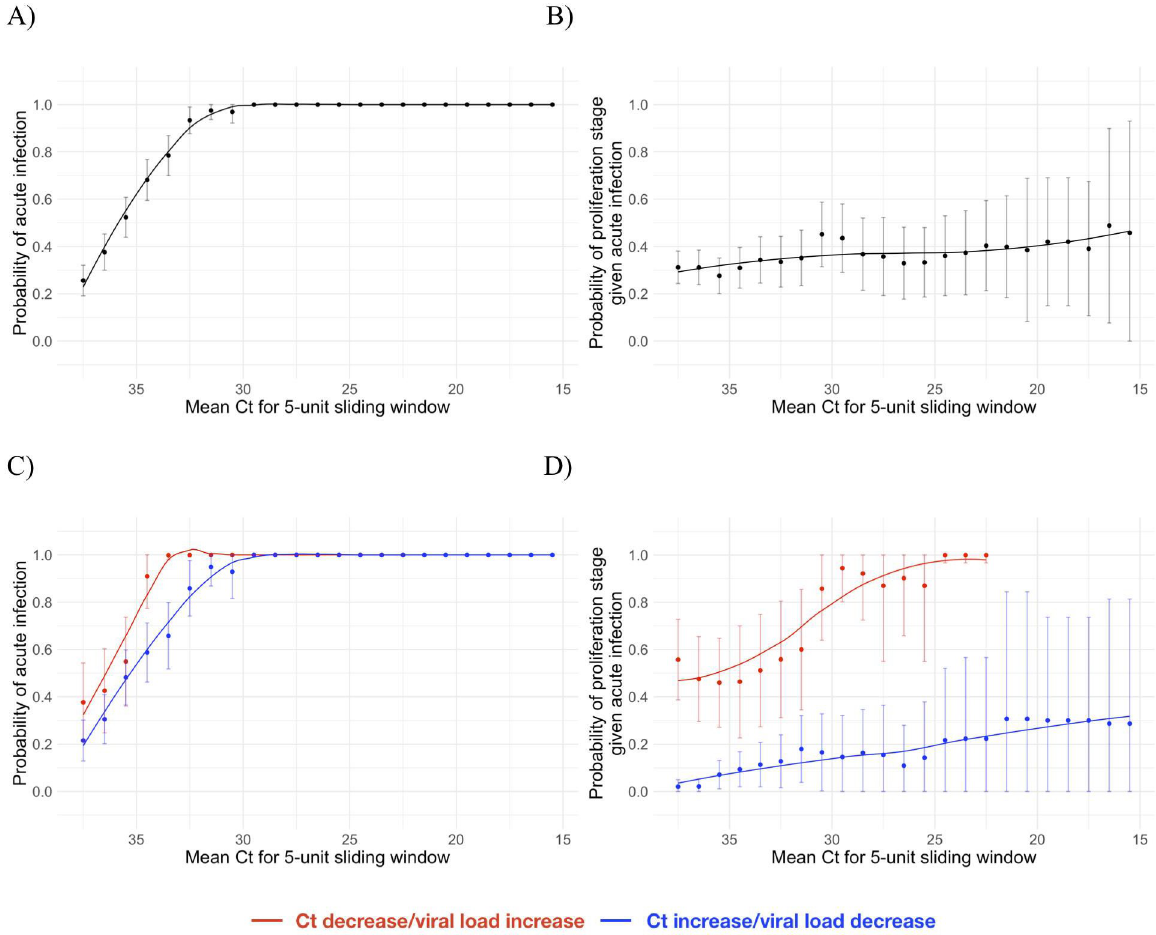
Fig 4. Relationship between single/paired cycle threshold (Ct) values and infection stage. Probability that a given Ct value lying within a 5-unit window (horizontal axis) corresponds to an acute infection (A and C) or to the proliferation phase of infection assuming an acute infection (B and D). (A) and (B) depict the predictive probabilities for a single Ct value, while (C) and (D) depict the predictive probabilities for a positive test paired with a subsequent test with either lower (red) or higher (blue) Ct. The curves are locally estimated scatterplot smoothing AU : PleasecheckthattheaddeddefinitionofLOESSiscorrect : (LOESS) curves to better visualize the patterns AU : PLOSstyleisforthewordtrendtobeusedonlywhereastatisticallysignificanttrendhasbeendemonstrated ; andnotforotherdescriptivepurposes : Ichangedthe 5 instancesinthepaperofthewordingtobettervisualizethetrendstotobettervisualizethepatterns : Ifthisisnotcorrect ; pleaseedit : . Error bars represent the 90% Wald confidence interval. Underlying data are available at https://github.com/ gradlab/CtTrajectories/tree/main/figure_data/Fig4 [10].